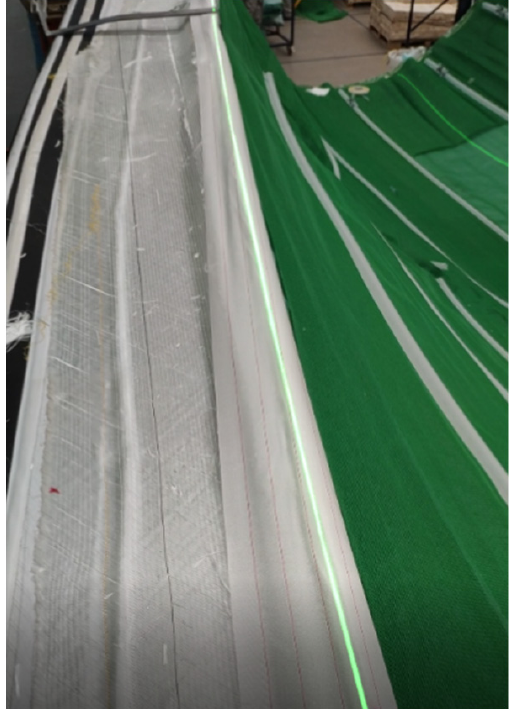
Figure 12. The initial state of projection imaging.